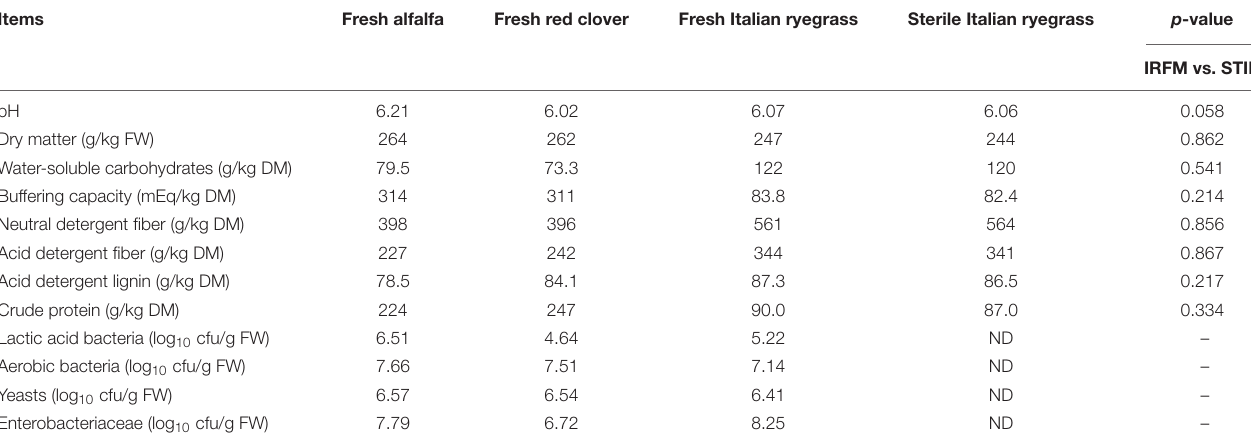
TABLE 1 | Chemical and microbial compositions of fresh forages and sterile Italian ryegrass before ensiling. Items Fresh alfalfa Fresh red clover Fresh Italian